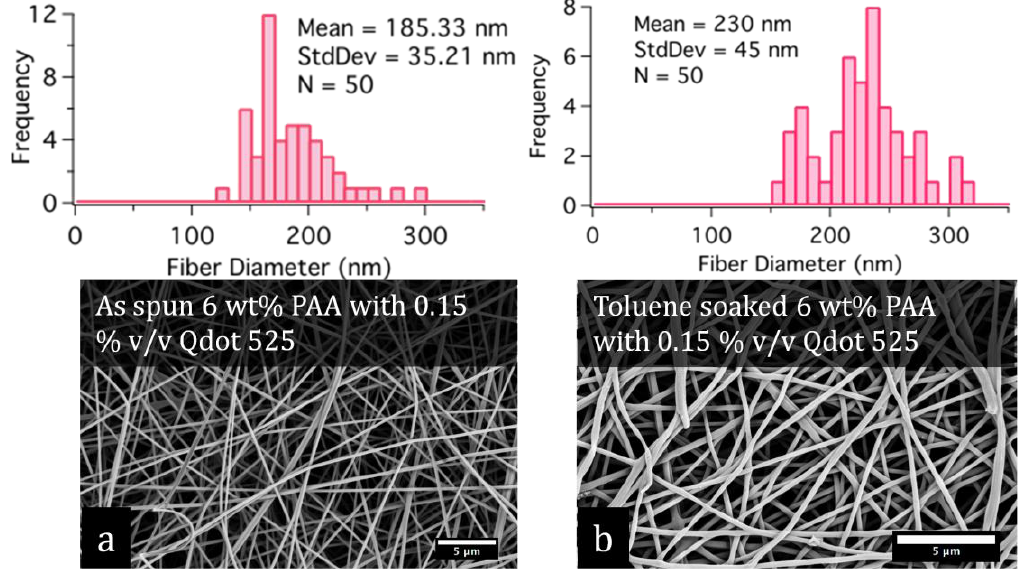
Figure 9. SEM micrographs of composite mats (a) as spun and (b) after soaking in toluene.